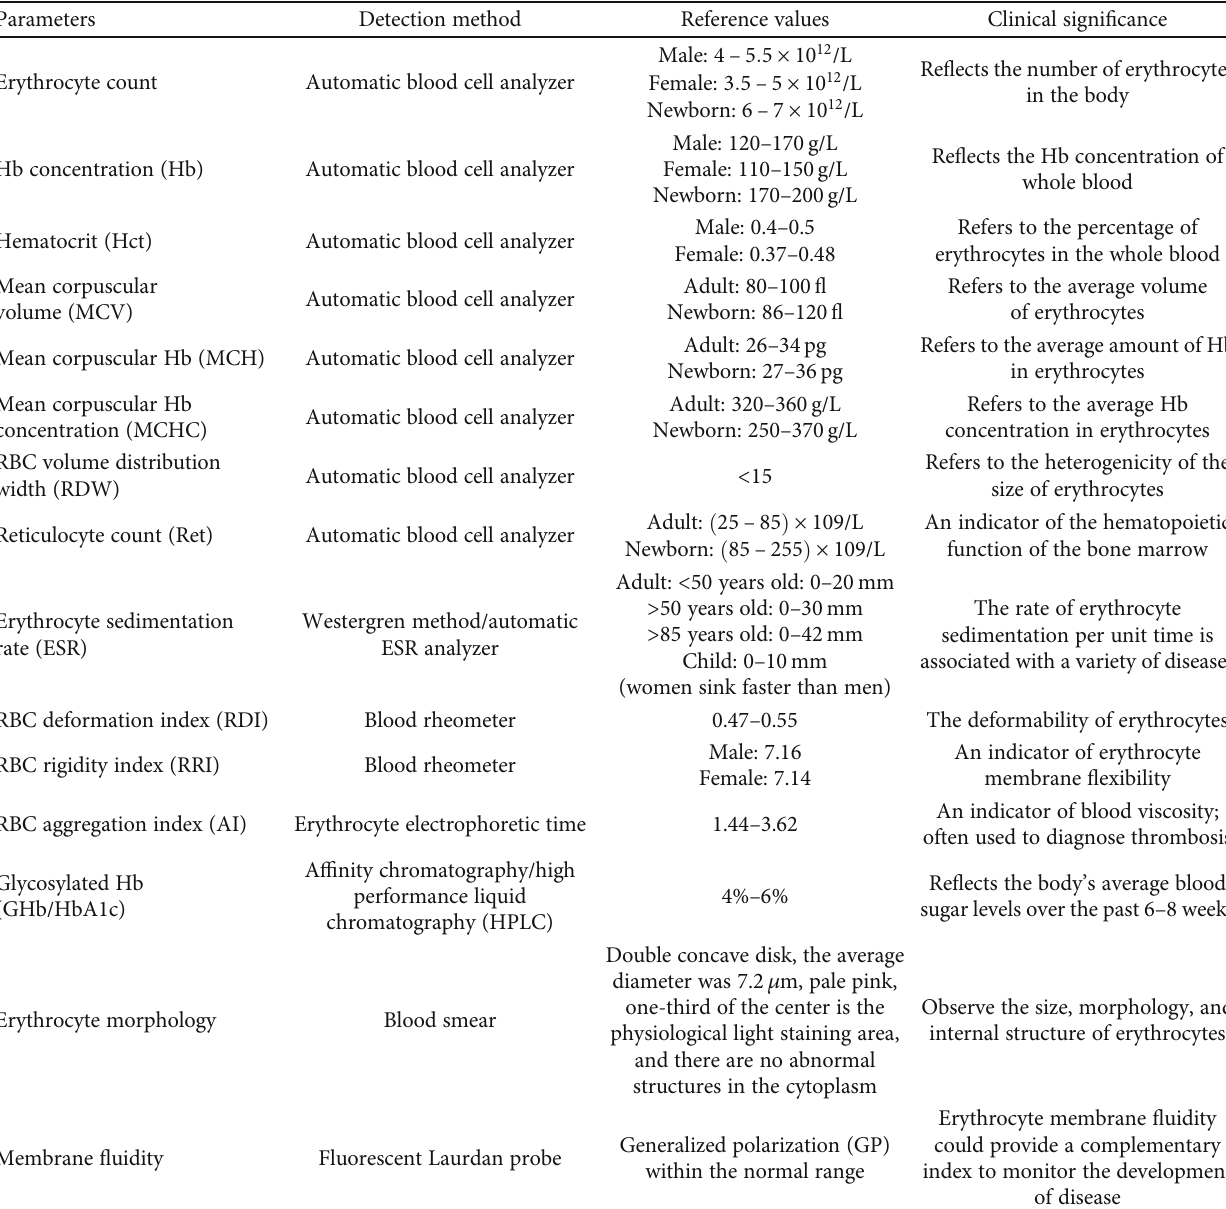
Table 1: Clinical erythrocyte